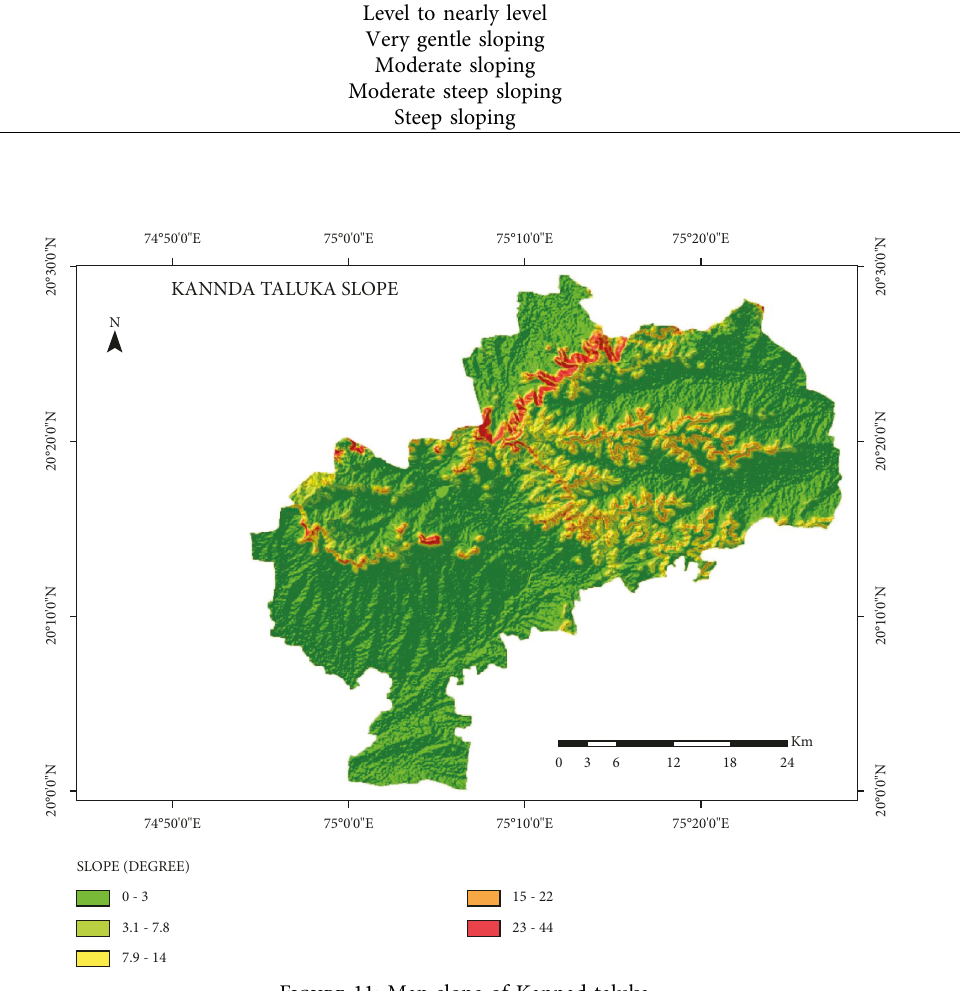
Figure 11: Map slope of Kannad